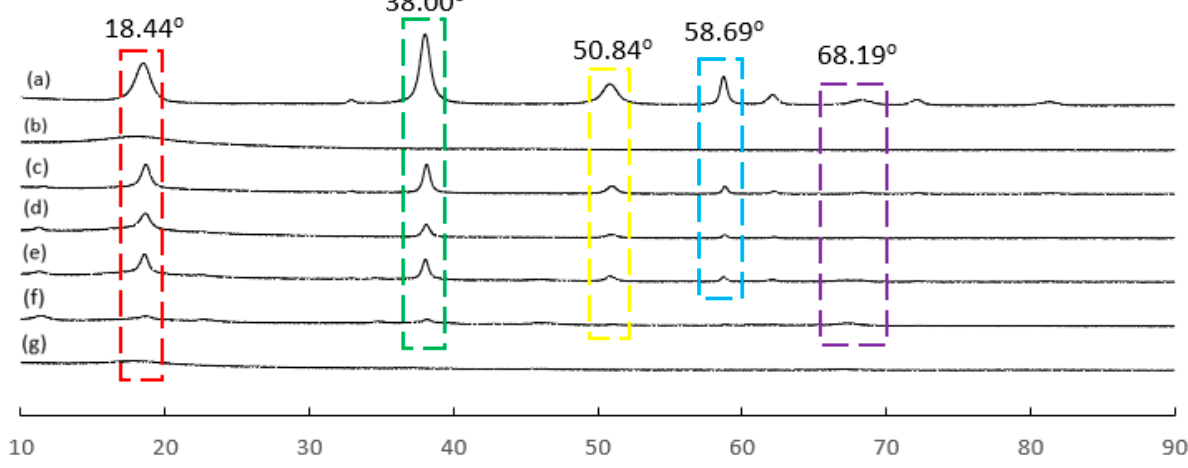
Figure 6. X-ray diffraction pattern of ( a ) HMO nanoparticles, ( b ) PES 0, ( c ) PES 1, ( d ) PES 2, ( e ) PES 3, ( f ) PES 4, and ( g ) PES 5.